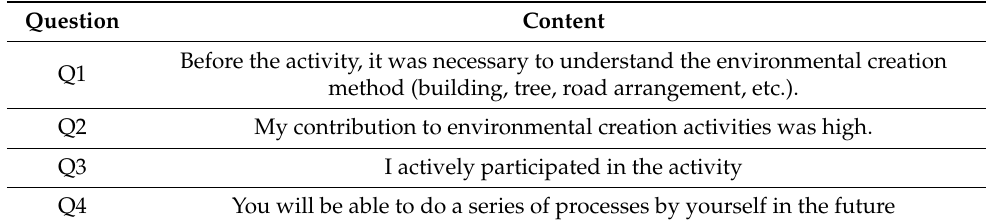
Table 3. Survey contents of cooperative